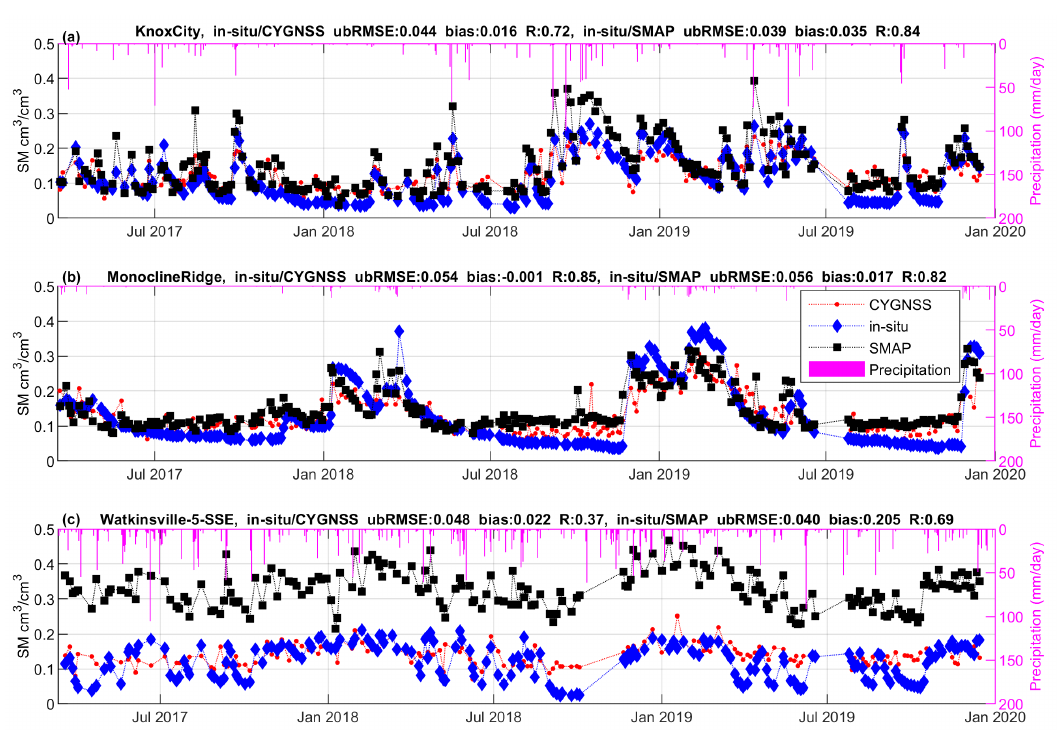
Figure 8. Time series examples of 3-day averaged CYGNSS and SMAP SM predictions that show a moderate performance: ( a ) KnoxCity, ( b ) MonoclineRidge, and ( c ) Watkinsville-5-SSE. The summary table of results from all sites are provided for the same time period in supplementary files.